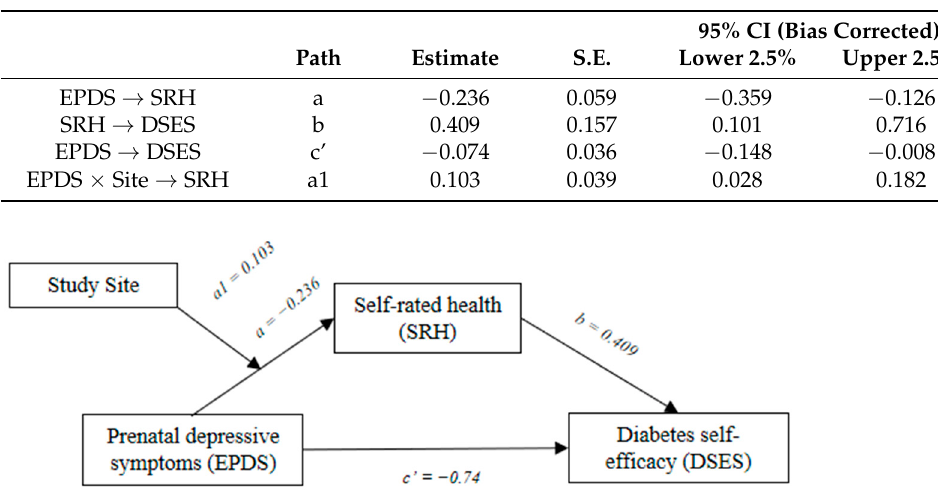
Table 4. Unstandardized estimates from the moderated mediation analysis.